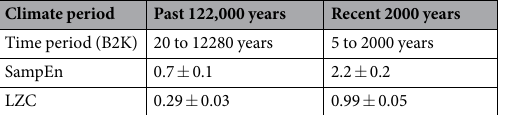
Table 1. SampEn values with m = 2 and r = 0.2 and LZC of two climate periods.